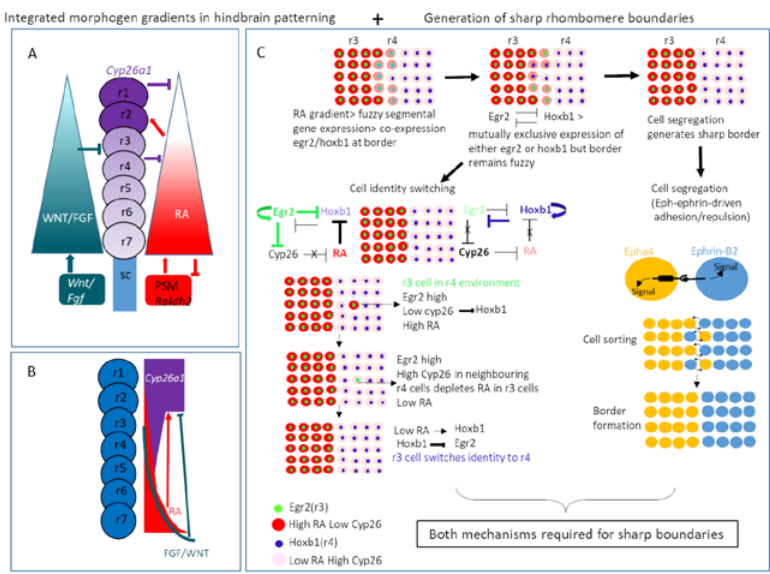
Figure 4. Regulation of RA availability by CYP26 enzymes in morphogen patterning of the hindbrain and generation of sharp rhombomere boundaries. ( A ) and ( B ). Integrated morphogen gradients in hindbrain patterning. Domains of RA synthesising enzyme Raldh2 in the pre-somitic mesoderm at the posterior of the hindbrain and high RA-degrading enzyme Cyp26a1 in the anterior neuroectoderm of the hindbrain plus lower Cyp26a1/c1 in more posterior hindbrain combined with inhibitory signals from an FGF/WNT signal gradient establish an RA gradient which is robust to RA fluctuation and adapts as the hindbrain grows larger (adapted from White et al. 2008 [159]). ( C ). Generation of sharp rhombomere boundaries requires Eph-Ephrin-mediated cell segregation and a cell identity switching mechanism driven by the RA status of the local environment. Cells of high egr2 , low cyp26b1 and high RA specify r3 identity. If these cells are present in an r4 environment, high cyp26b1 in surrounding r4 cells leads to depletion of RA in the r3 cell, this induces hoxb1 expression which represses egr2